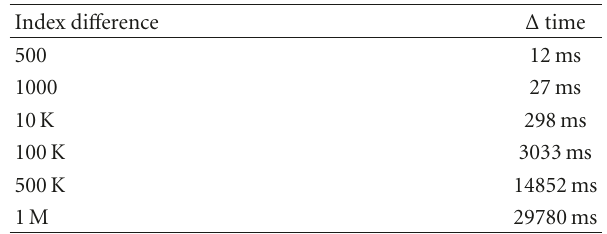
Table 1: The configuration used in the experiments. Table 2: Timing attack on Rhee’s protocol [3].